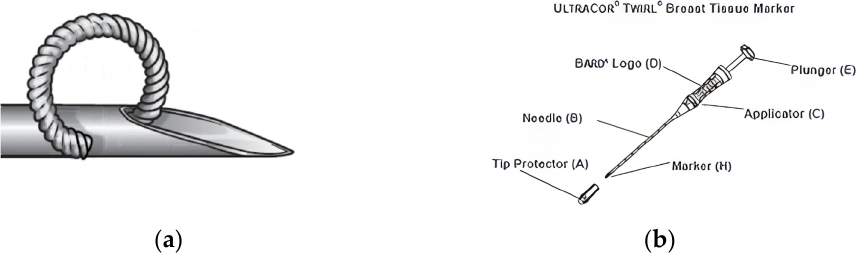
Figure 1. Ultracor Twirl clip ( a ) and applicator ( b ).